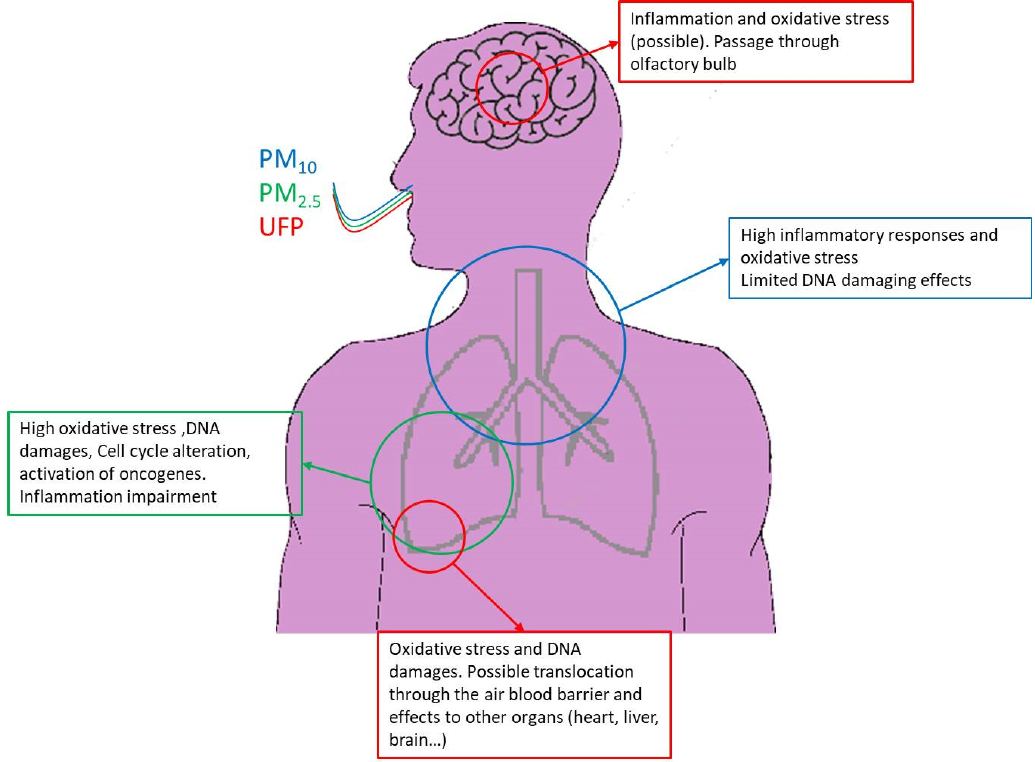
Figure 1. Summary of adverse effects determined in in vitro systems exposed to particulate matter with mean aerodynamic diameter lower than 10 µm (PM 10 ), fine particulate matter, lower than 2.5 µm (PM 2.5 ), and ultrafine particle matter (UFP). PM 10 coarse particulates deposit in the upper